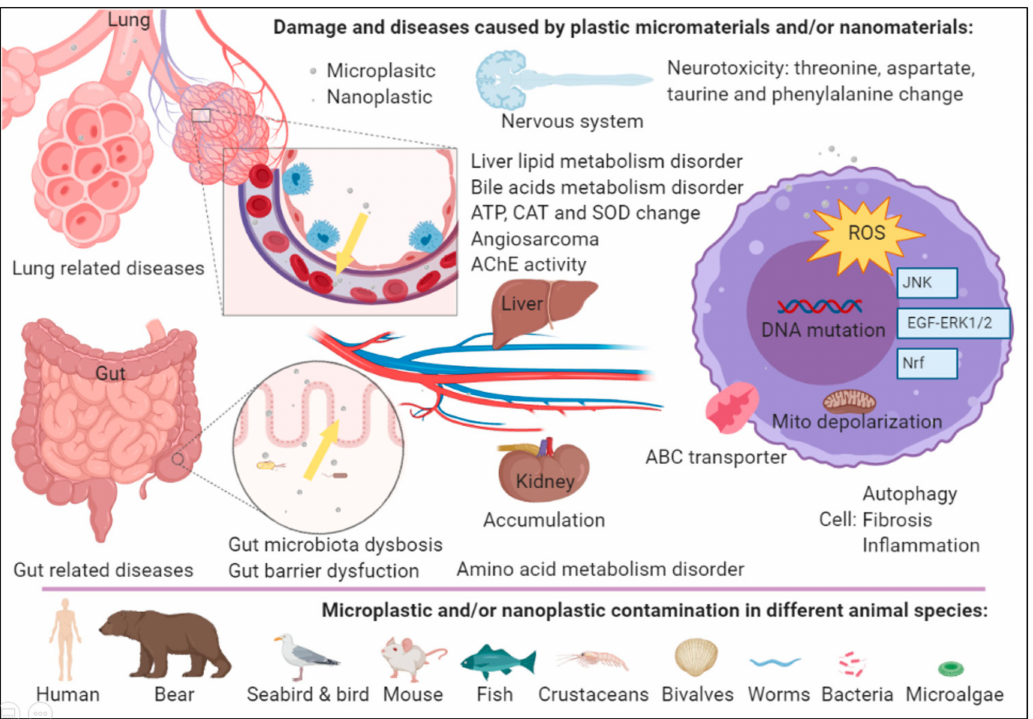
Figure 3. Impact of plastic micromaterials and nanomaterials in organisms. Microplastics and / or nanoplastics can enter the circulation from the gut and lungs and accumulate in the gut, liver, and kidney resulting in several diseases. At the cell level, microplastics or nanoplastics can inhibit the e ffl ux pump and mitochondria depolarization, induce reactive oxygen species (ROS). They also a ff ect several signaling pathways, cause fibrosis, autophagy, and even DNA mutations. Many animal species have been contaminated by microplastics and / or nanoplastics. The figure was created with